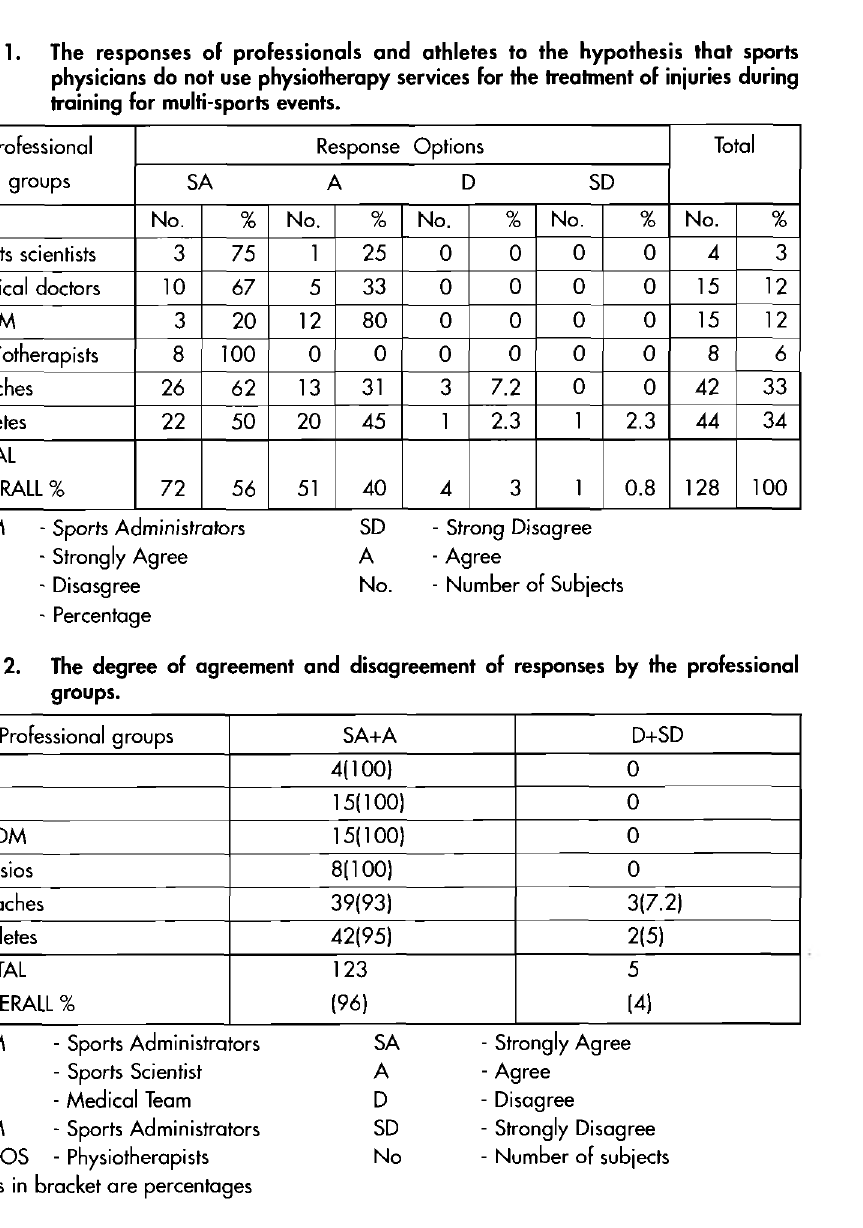
The degree of agreement and disagreement of responses by the professional